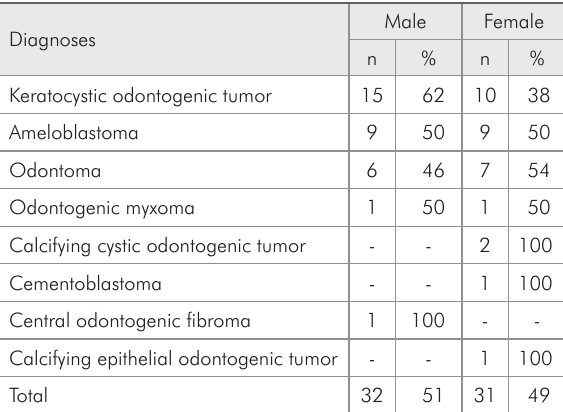
Table 2 - Cases diagnosed distributed by